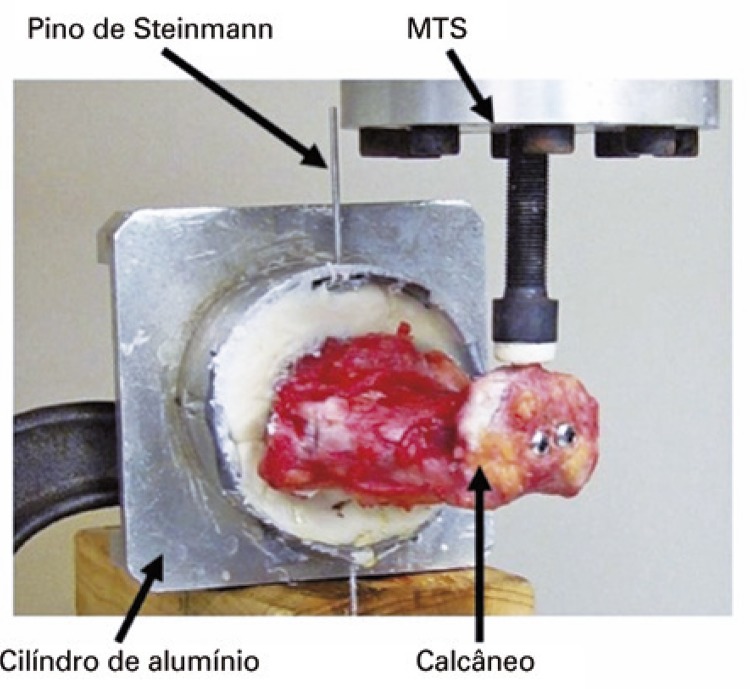
Configuração experimental. O tálus é fixado dentro no cilindro de alumínio. Um pino de Steinmann é colocado para manter o tálus no lugar. As porções mediais do tálus e do calcâneo estão viradas para cimaMTS: Bionix®858 MTS.